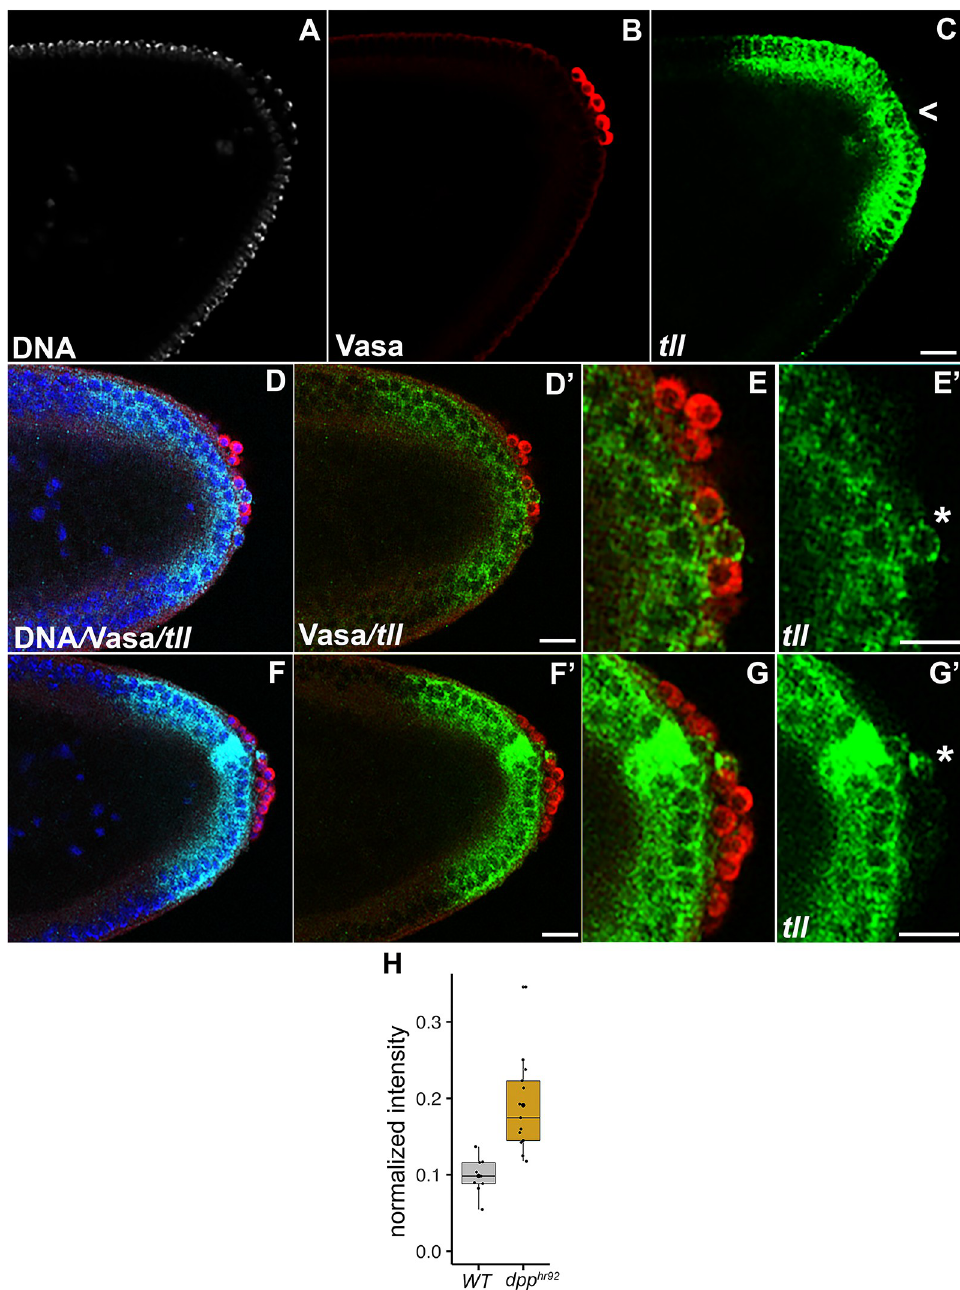
Fig 4. dpp -compromised embryos show PGC-specific aberrant transcription of the terminal patterning gene tailless ( tll ). (A-C) WT and (D-G) dpp hr92 embryos were simultaneously stained for Vasa (red) and probed for tll RNA (green) using FISH. Nuclei were labeled using Hoescht (white/blue). Panels E and G show enlarged regions of Panels D’ and F’, respectively. Scale bar represents 10 μ m. H) Plot below displays normalized density value of tll transcripts in PGCs relative to soma in the same embryo (see Materials and Methods for details of